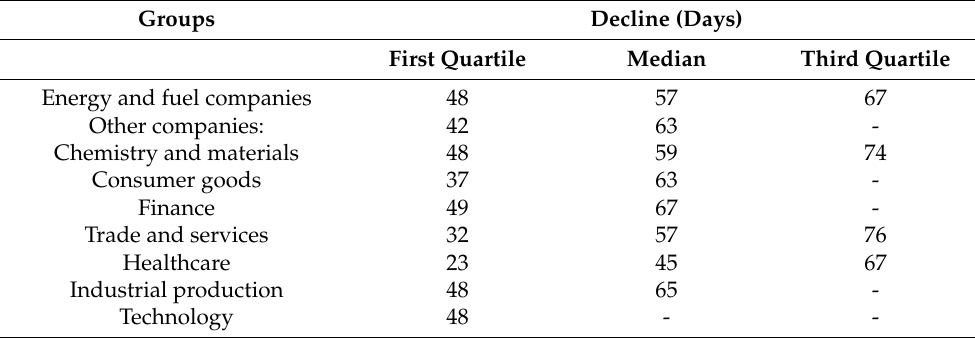
Table 2. Quartiles of survival for macro sectors. Source: own elaboration on the basis of data from